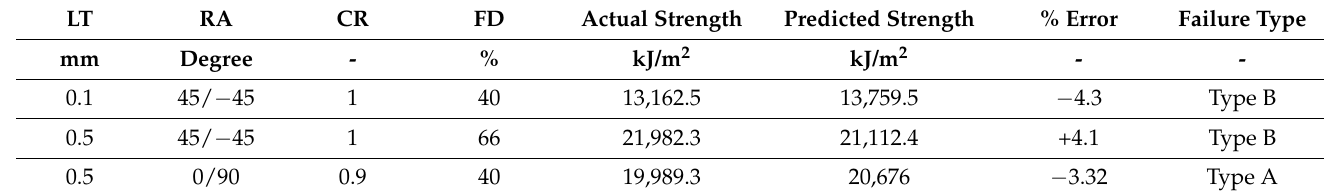
Table 7. Experimental vs. predicted